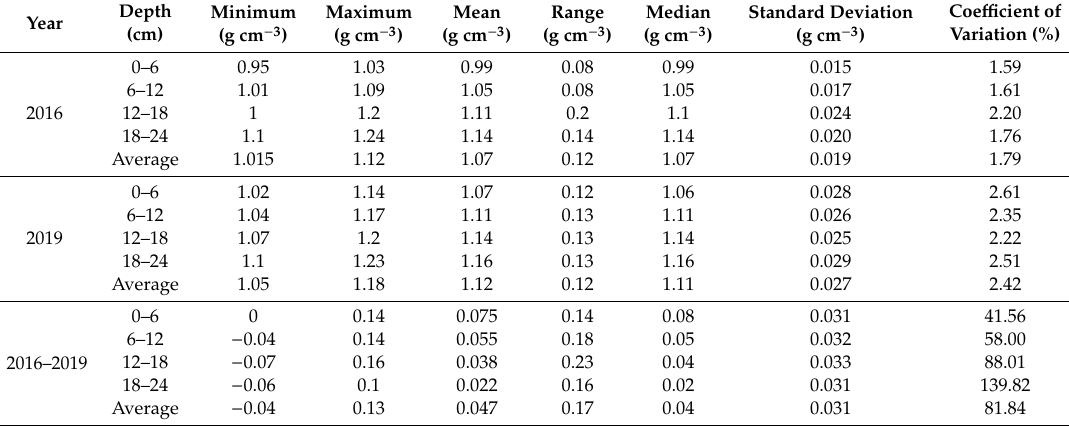
Table 1. Descriptive statistics of soil bulk density (Bd) using field core measurements.